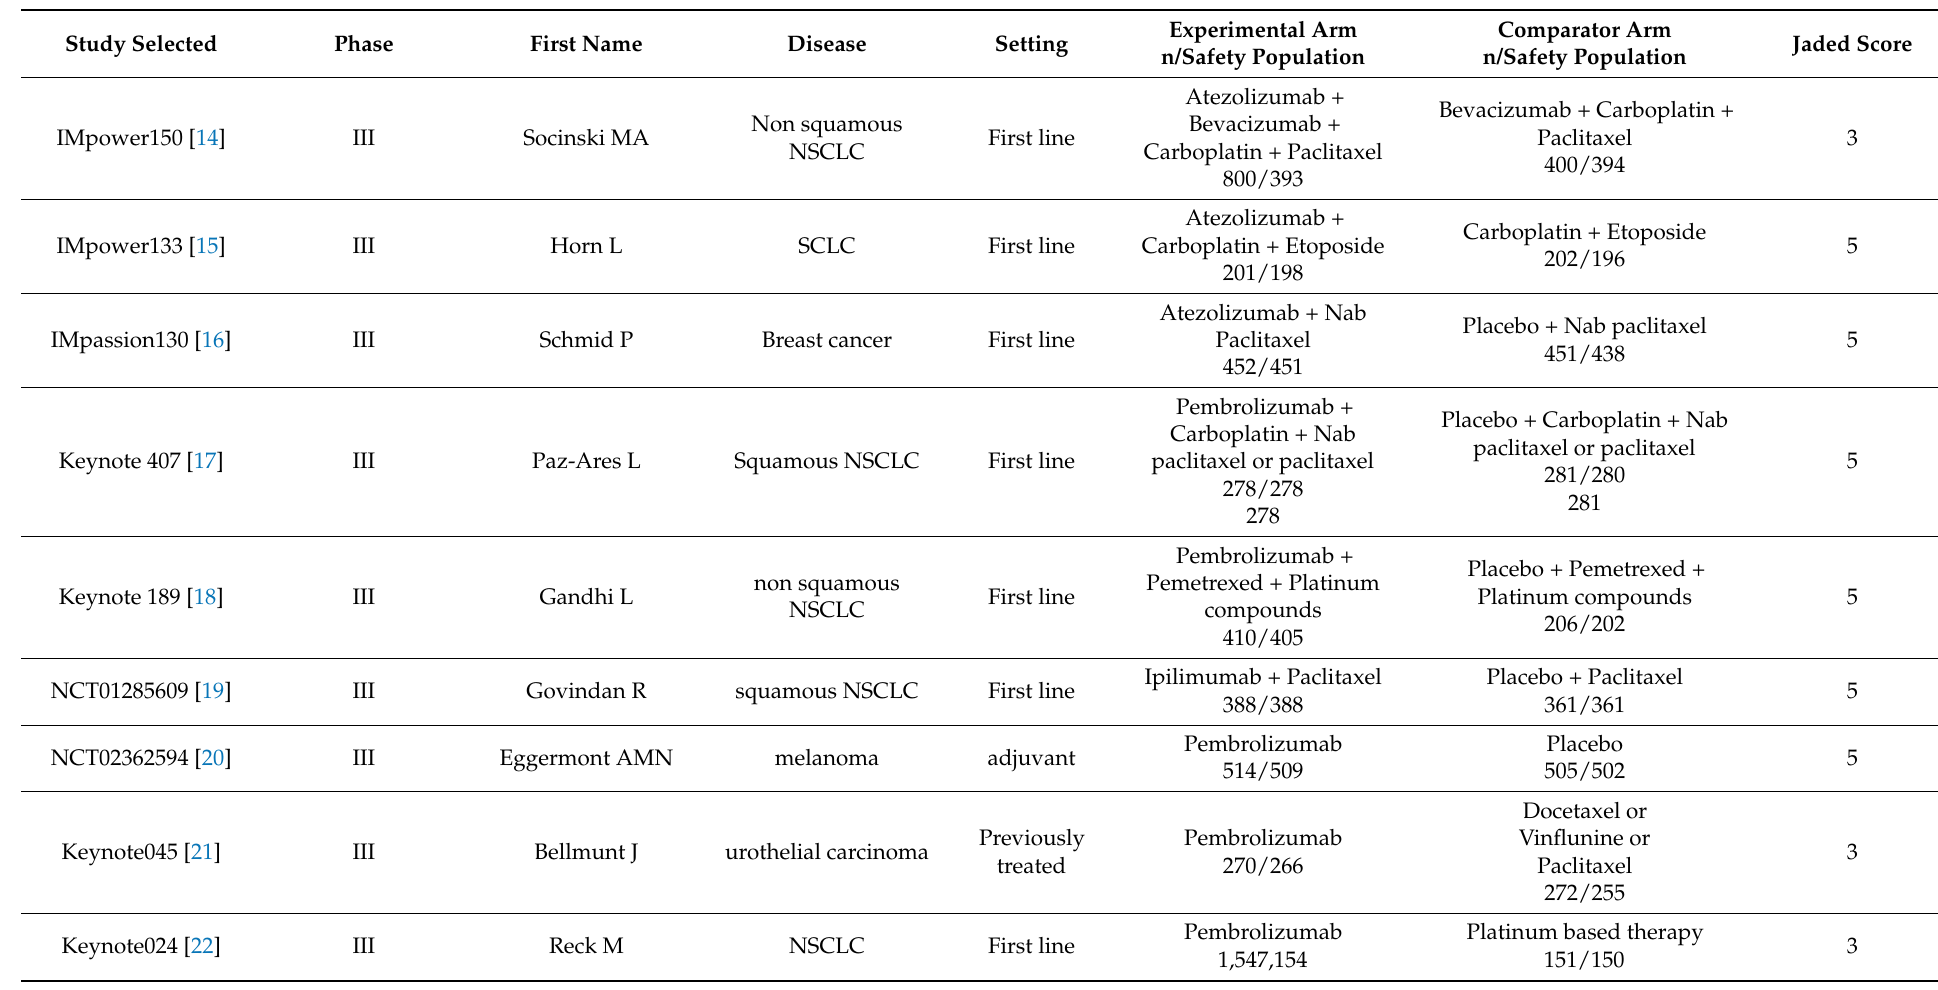
Table 1. Studies included; for each study, we reported: study name, phase, experimental and comparator treatment arm, disease, setting, population on study, safety population and JADED